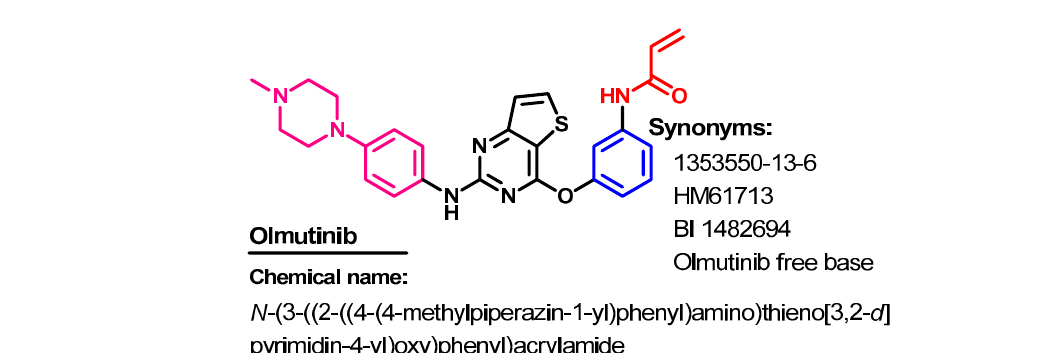
Figure 48. Chemical structure/name/synonyms of olmutinib.